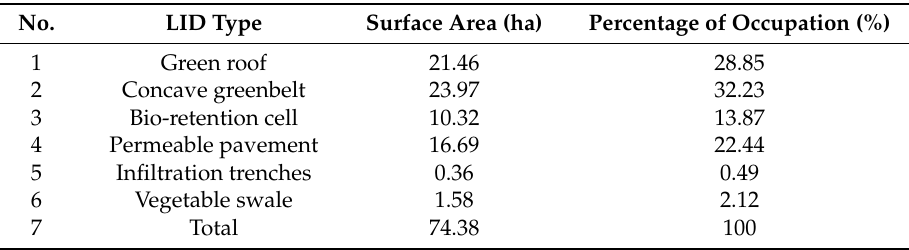
Table 5. Area of different LID types.